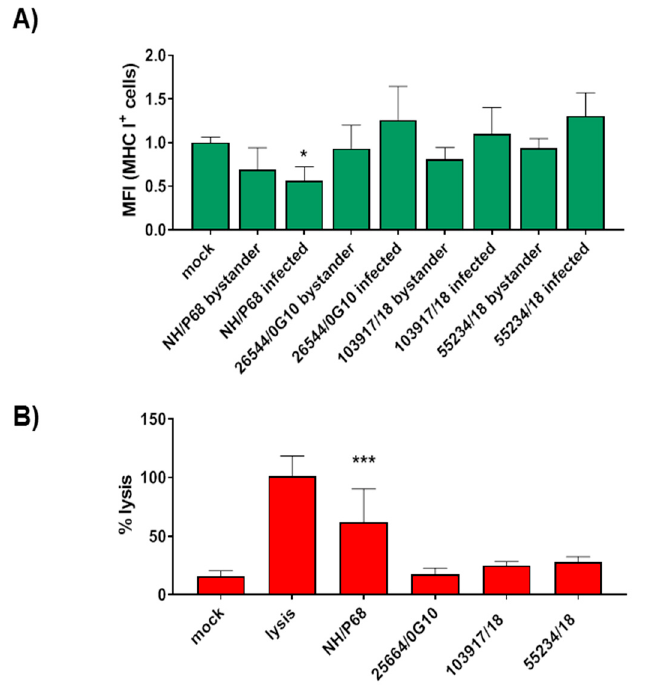
Figure 3. Effect of 103917/14 and 55234/18 ASFV infection on MHC class I expression and viability of macrophages. moM Φ were infected with the low-virulence NH/P68, the virulent 26544/OG10, or the isolates under study 103917/18 and 55234/18 using an MOI of 1, alongside mock-infected controls. At 21 hpi, surface expression of MHC class I and moM Ф viability were assessed. ( A ) MHC class I expression (MFI) and intracellular levels of ASFV p72 were assessed by flow cytometry; MFI data are presented as fold change relative to the mock-infected condition. Values of ASFV-infected or bystander macrophages were compared to the corresponding mock-infected control. ( B ) moM Ф viability was assessed using a non-radioactive cytotoxic assay, which quantifies lactate dehydrogenase (LDH) levels in culture supernatants. For both panels, mean values and standard deviation from three ( A ) or four ( B ) independent experiments utilizing different animals are shown as green and red bars with whiskers lines, respectively. Analysis of variance and relative Bonferroni method for multiple comparisons were applied to evaluate difference between samples; *** p < 0.001, * p < 0.05.